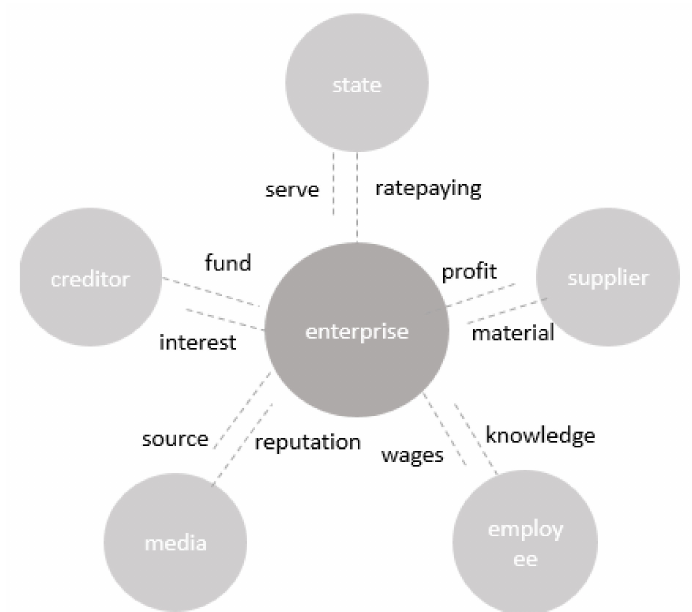
Figure 1. Stakeholder influence